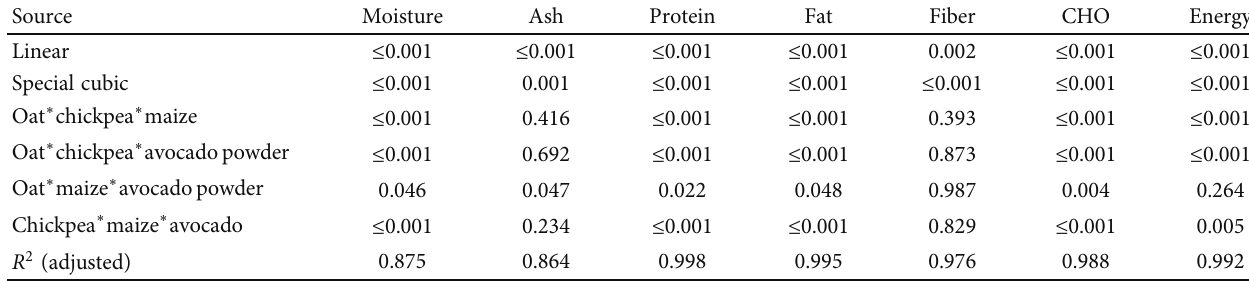
Table 2: Full cubic regression model ANOVA p values and model coe ffi cients for proximate composition of formulated complementary food samples.